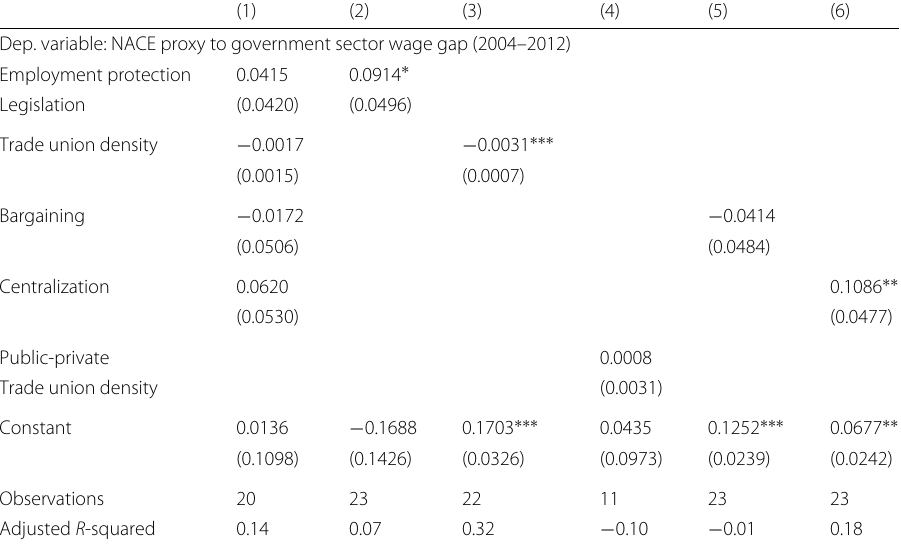
Table 3 Determinants of the public sector pay gap: different wage-setting institutions (1) (2) (3) (4) (5)